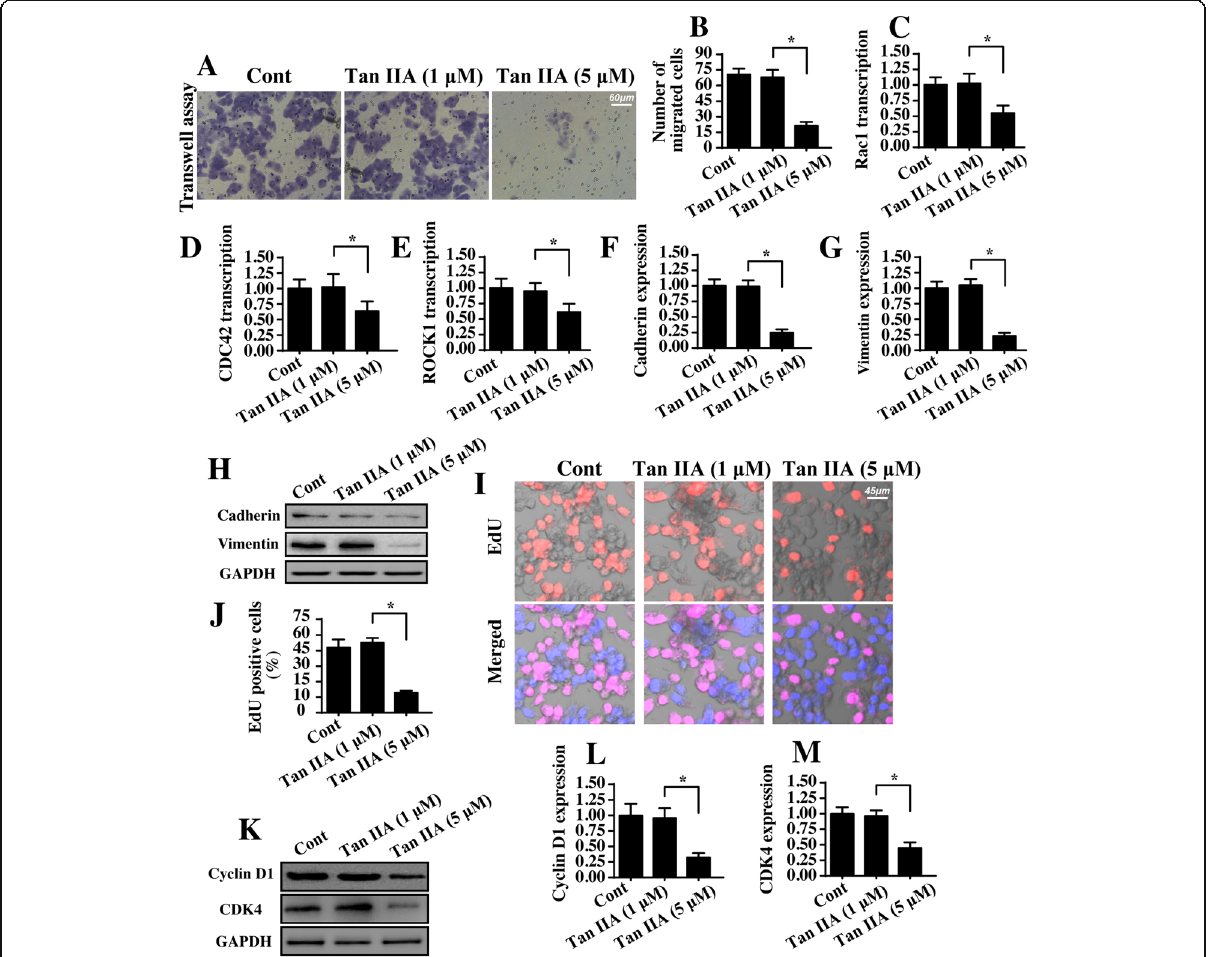
Fig. 2 Tan IIA inhibits cancer cell proliferation and migration. a-b The transwell assay was used to analyze the cell mobility. The number of migrated cells was recorded. Tan IIA at 1 μ M and 5 μ M were incubated with SW837 cells for 12 h. c-e qPCR assay for metastatic gene transcription. Compared to the control group, Tan IIA significantly increased the transcription of Rac1, CDC42, ROCK1. f-h The expression of adhesive factors were determined via western blotting. i-j EdU staining for cell proliferation. The number of EdU-positive cells was recorded. k-m Western blotting analysis for proliferation-related proteins. SW837 cells were treated with 1 μ M or 5 μ M Tan II for 12 h. * p <